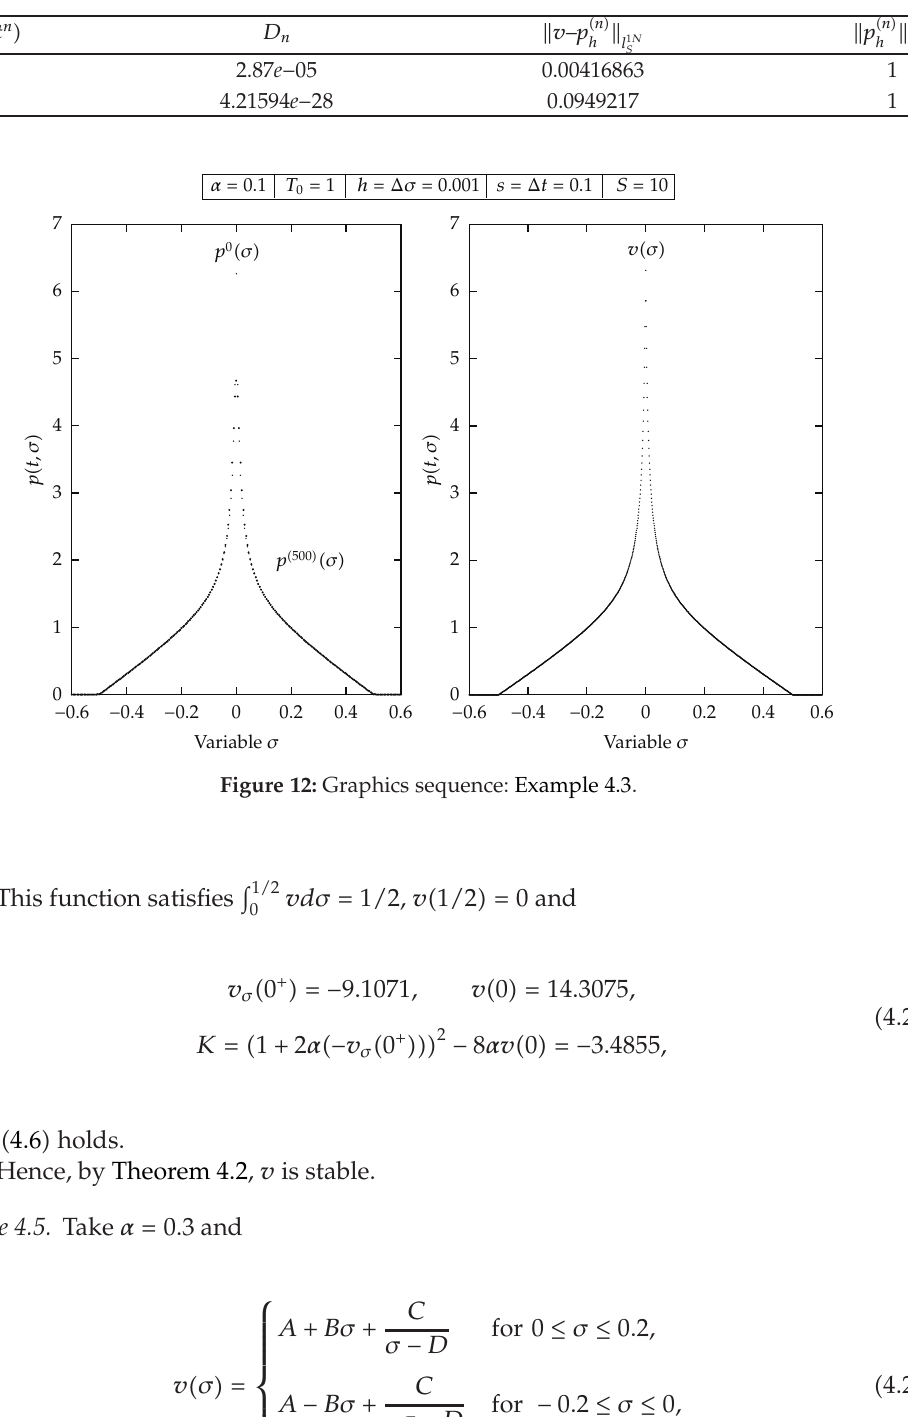
Table 10: Numerical results: Stable fixed point.